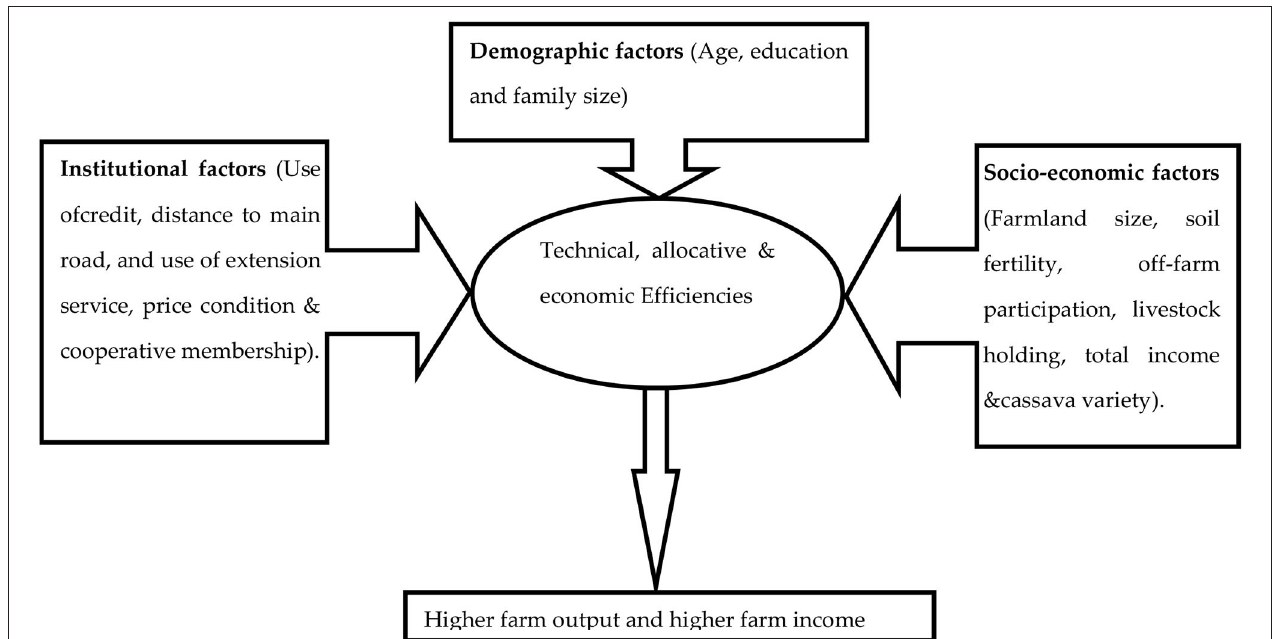
FIGURE 2 | Conceptual framework.